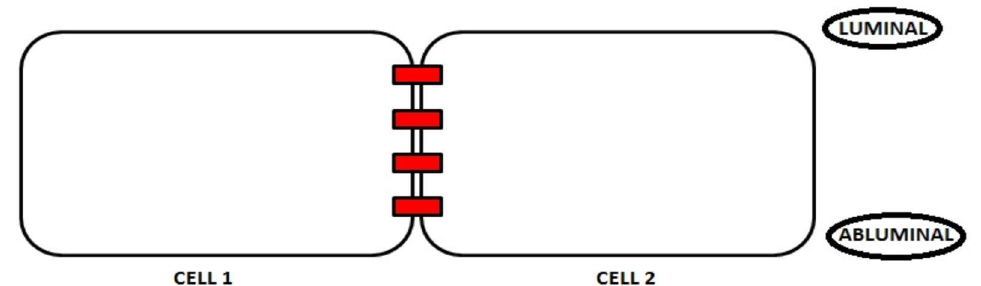
Figure 2. Localization of the luminal and abluminal sides of brain endothelial cells. The luminal and abluminal membrane domains are separated by tight junctions.